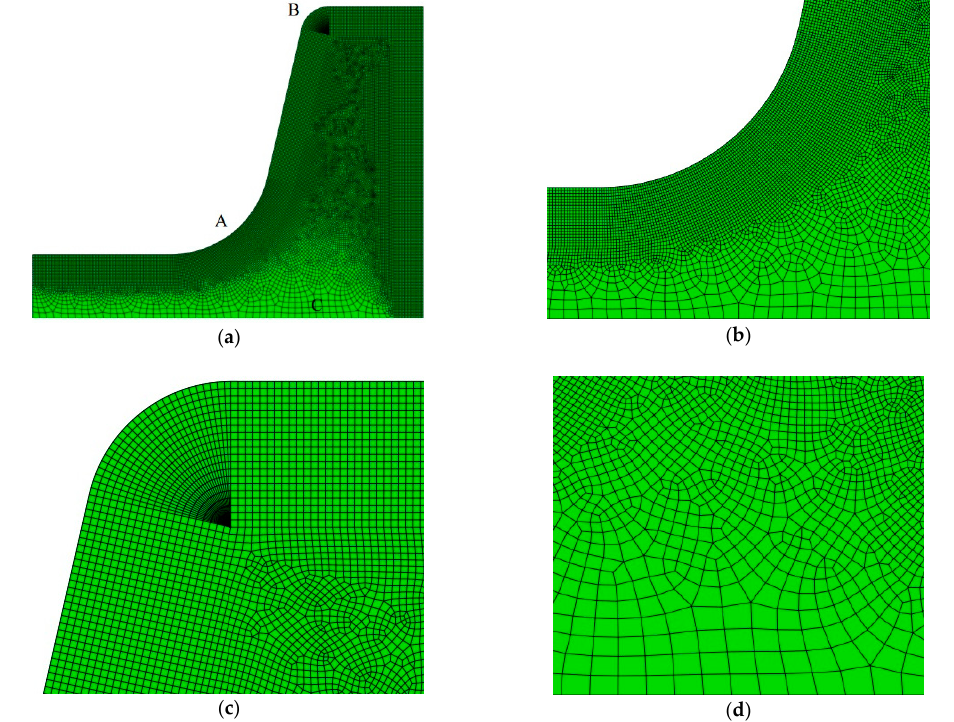
Figure 3. ( a ) Whole elements; ( b ) elements near point A; ( c ) elements near point B; ( d ) elements near point C.